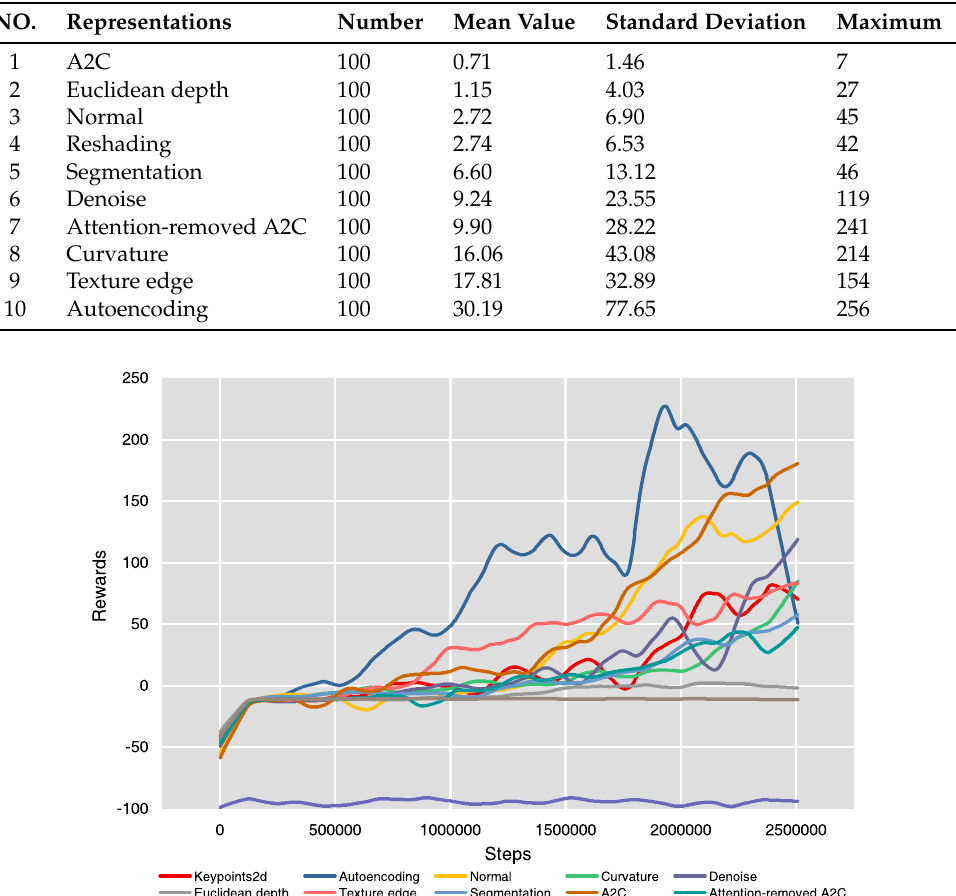
Table 4. (Sorted by Mean value in ascending order) Number of collisions caused by agents with